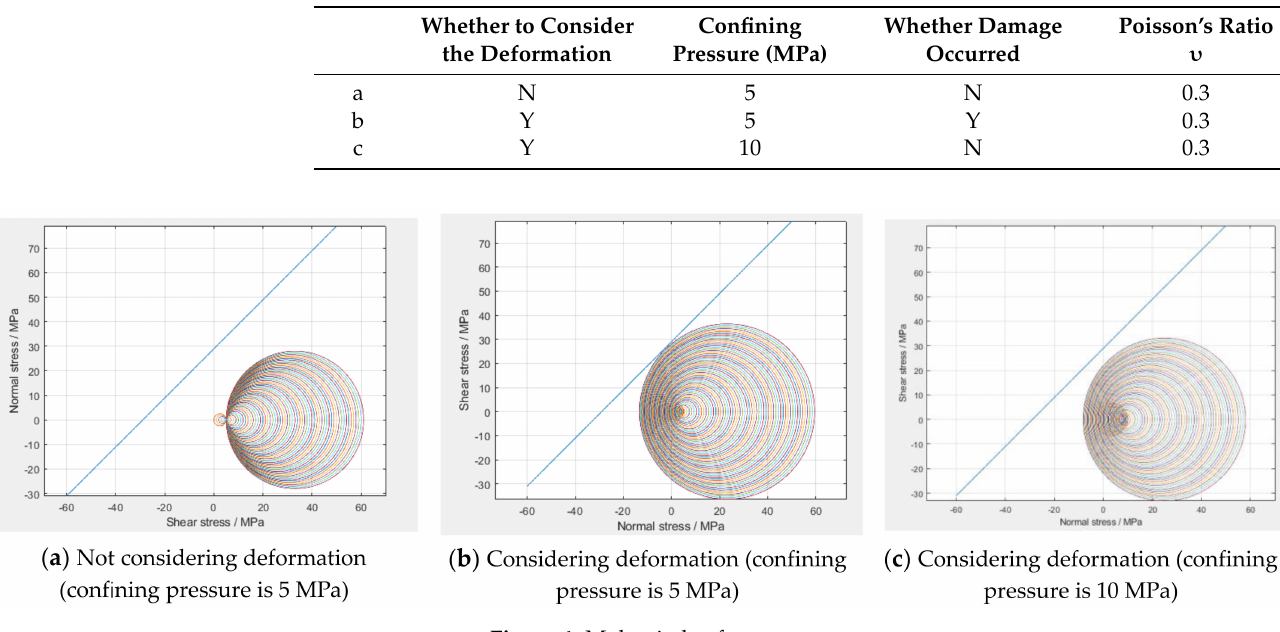
Figure 4. Mohr circle of stress.